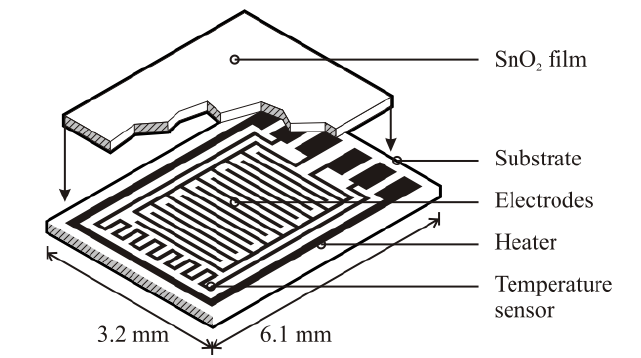
Figure 2. Schematic of the sensor platform (Heraeus MSP 632). The sensing and heating circuits are not drawn to scale.